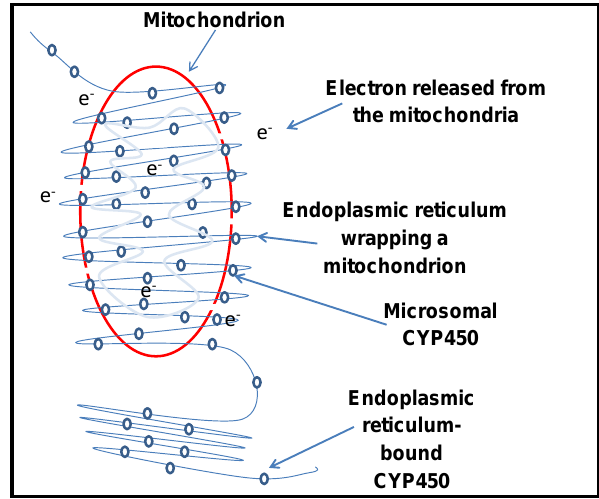
Figure 8. Represents a schematic diagram illustrating the possible activation of cytochrome P450 enzymes during minimal expression of Bax and also shows the potential communication between the mitochondria and endoplasmic reticulum (ER), displaying their strong ties and dynamics with their all-encompassing contact.